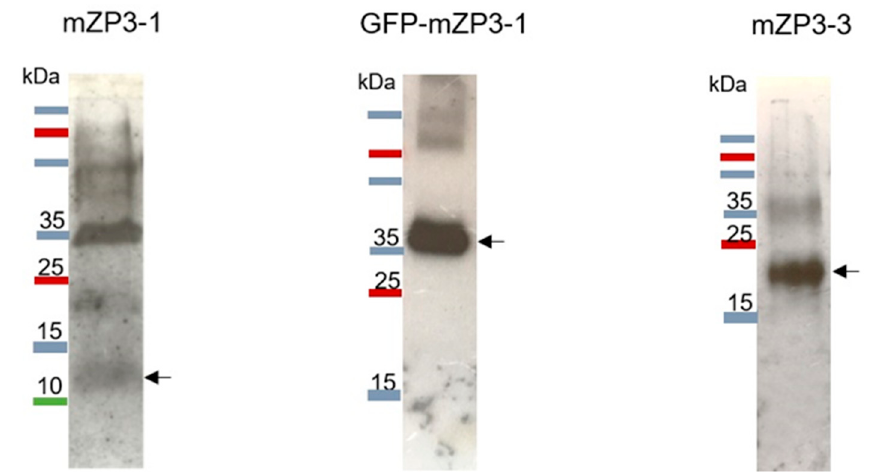
Figure 5. Detection of purified plant-expressed recombinant proteins using Ni-NTA affinity chro- matography. Western blot of the 30× concentrated elution fraction from mZP3-1 in comparison to the unconcentrated elution fraction from GFP-mZP3-1 and mZP3-3. Arrows indicate the bands at the expected size of the glycosylated proteins. Western blots probed with mouse anti-His monoclonal antibodies. Blots cropped for clarity, for uncropped blots see Figure S5. For Coomassie-stained SDS-PAGE of purified plant-expressed recombinant proteins, see Figure S6. Table 1. mZP3 accumulation levels in crude plant extract and in purified antigens, as determined using